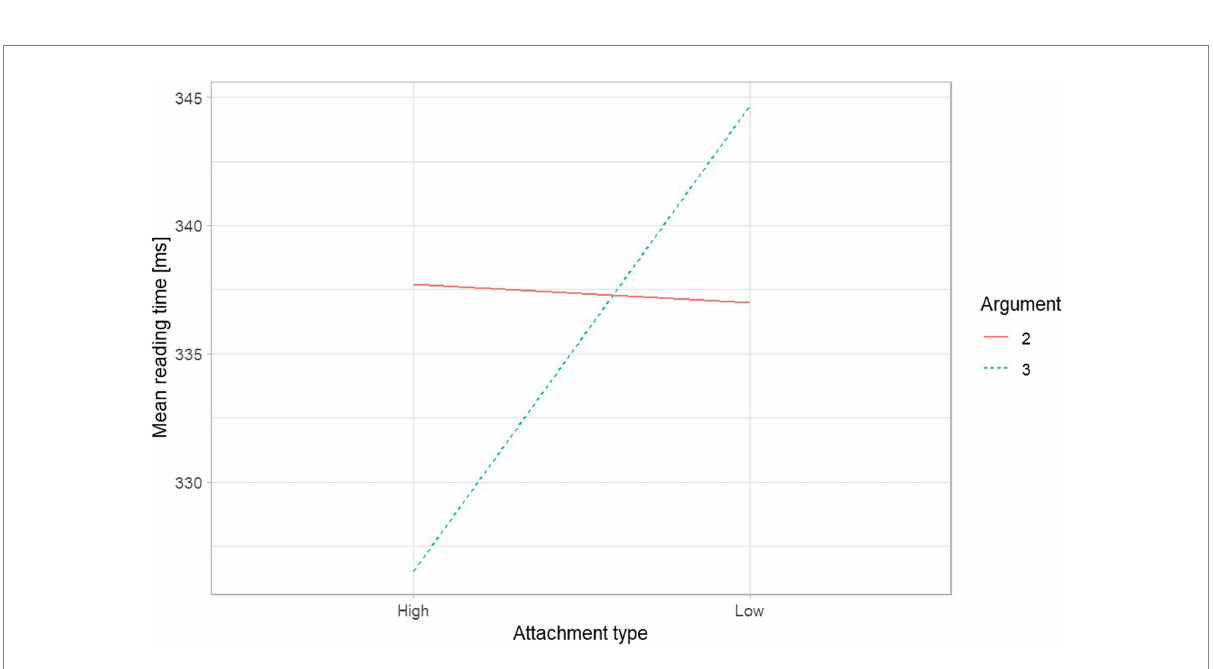
FIGURE 3 The interaction plot from the global model for region 2: the preposition in